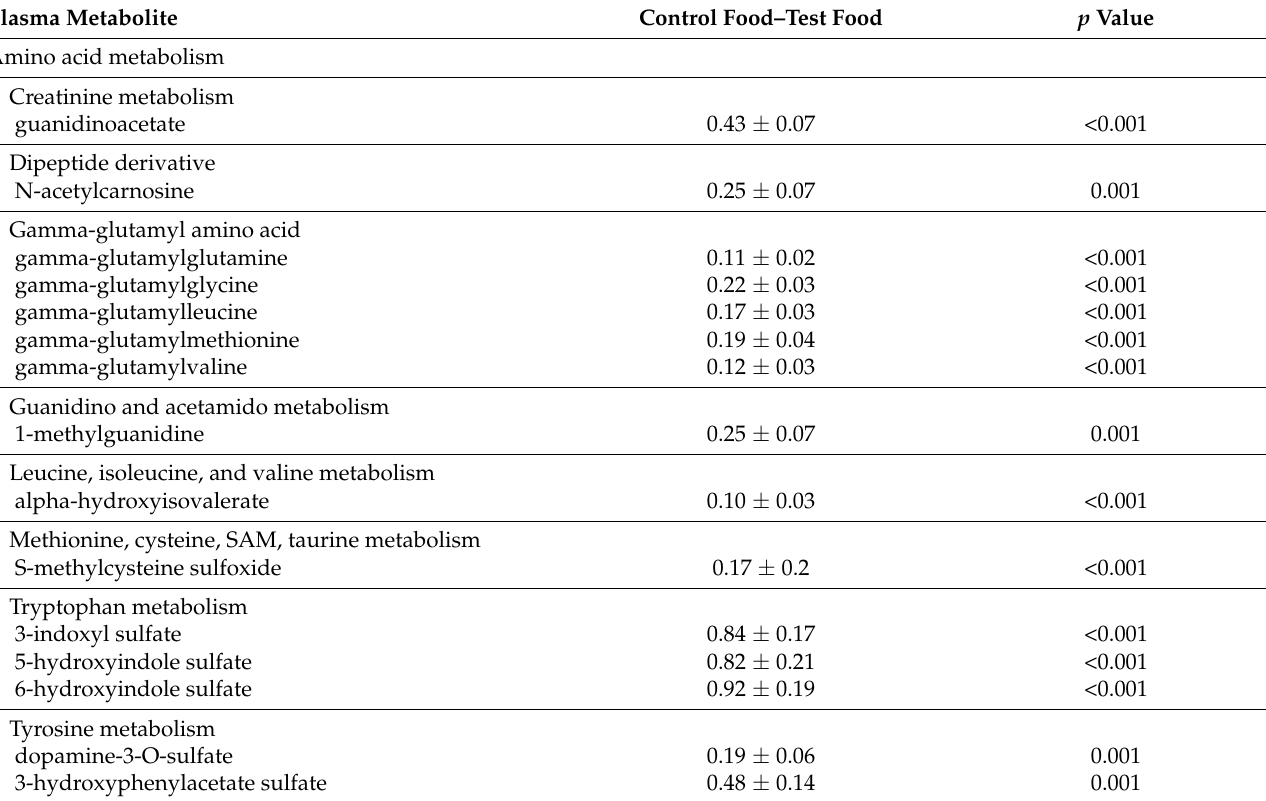
Table 5. Plasma metabolites of interest following consumption of study foods by senior